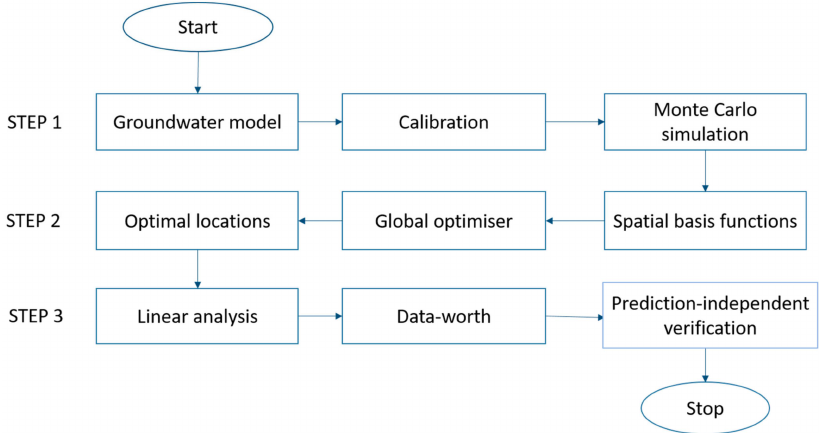
Figure 1. Workflow for optimal monitoring network design and data-worth